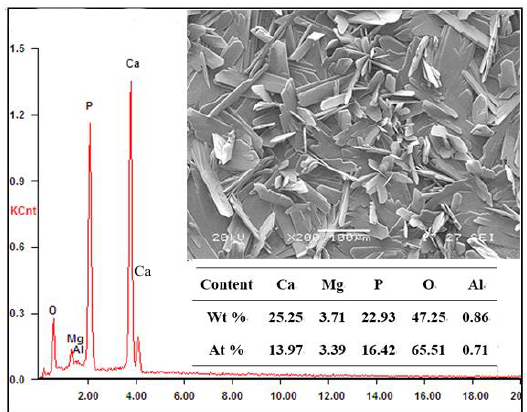
Figure 8. SEM micrograph of the Ca-P conversion coating and the correspondent EDS analysis.